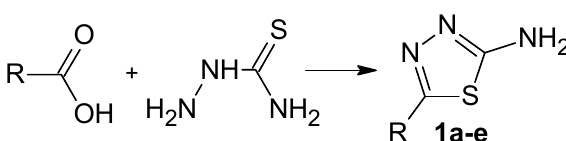
Molecules 2021 , 26 , x FOR PEER REVIEW I Table 1. List of 2-amino-1,3,4-thiadiazoles synthesized using the developed ap- proach (Scheme 1). thiosemicarbazide and different carboxylic acids in the presence of PPE as a new approach to a 2-amino-1,3,4-thiadiazole one-pot synthesis.